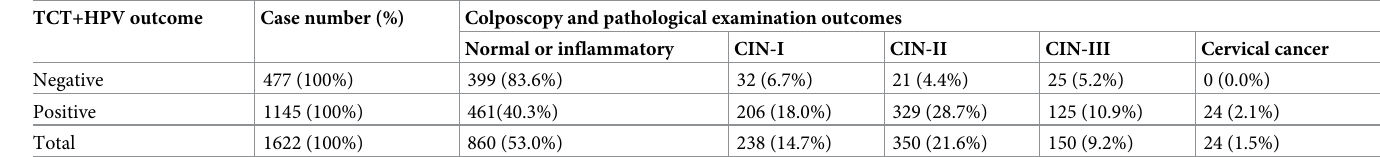
Table 4. Analysis of the TCT+HPV testing and pathological examination outcomes for 1622 patients with cervical lesions.